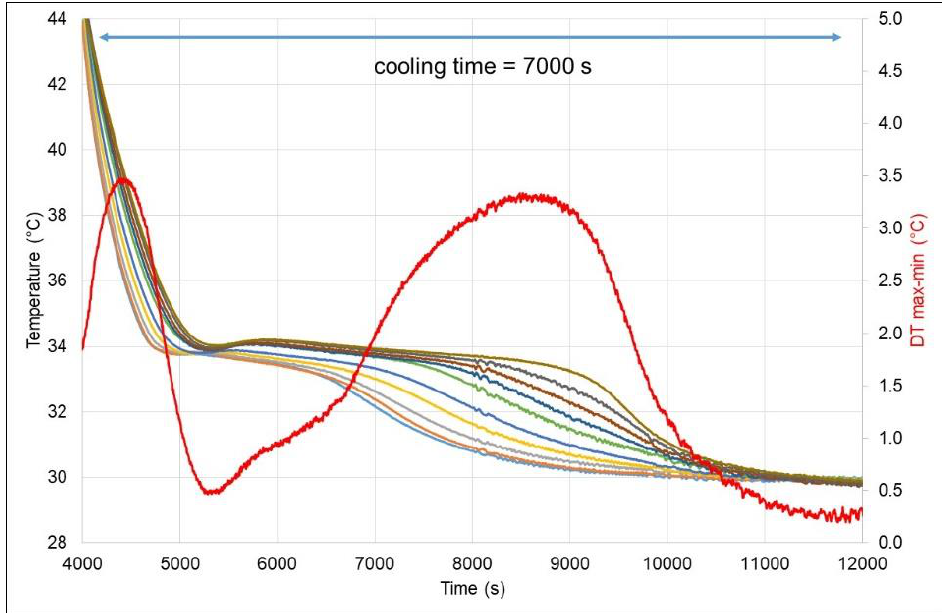
Figure 18. Measured surface temperature of the cells when the cooling airflow was characterized by a speed of 1 m/s. The heating elements were off over the time period indicated in the chart.